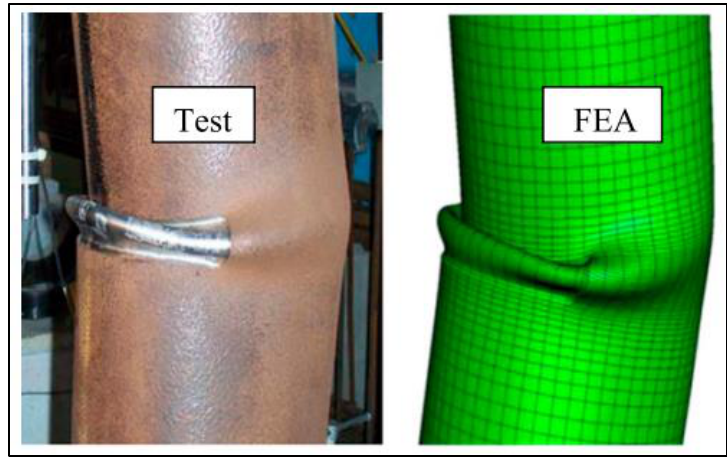
Figure 3. Outward bulge buckling at the corrosion defect region [21].